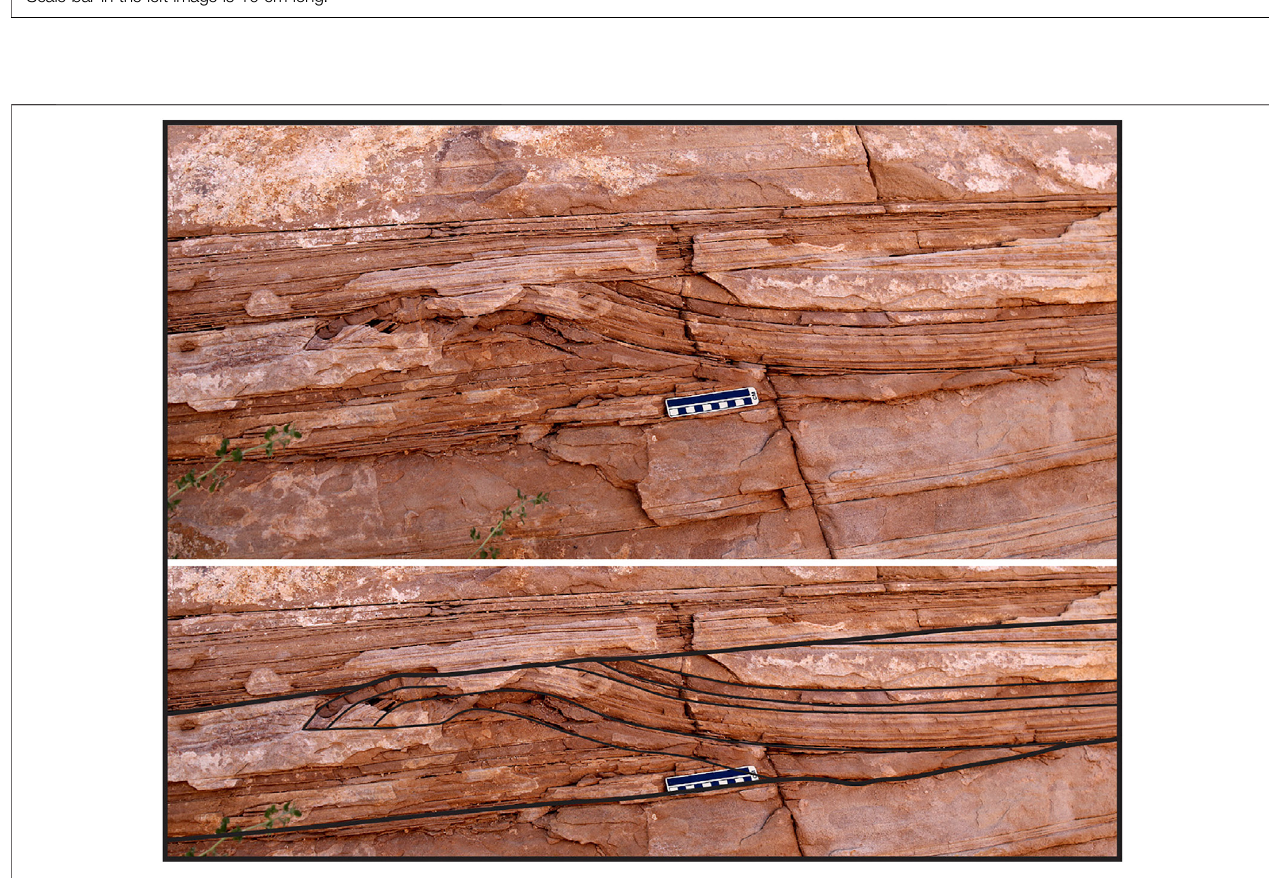
FIGURE 6 | Cross-sectional view of an overthrust fold as seen in a vertical quarry wall; the upper part of this folded feature has been truncated by the overlying sandstone layer. The top photo is unmarked and the bottom photo is annotated to highlight the internal contorted laminations.